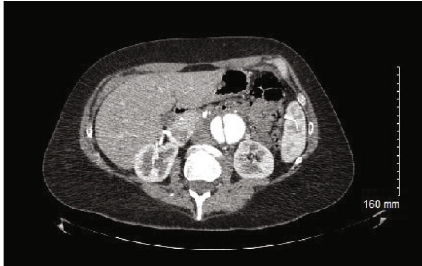
Figure 1: CT scan of the abdomen/pelvis with IV contrast demonstrating dissection of the abdominal